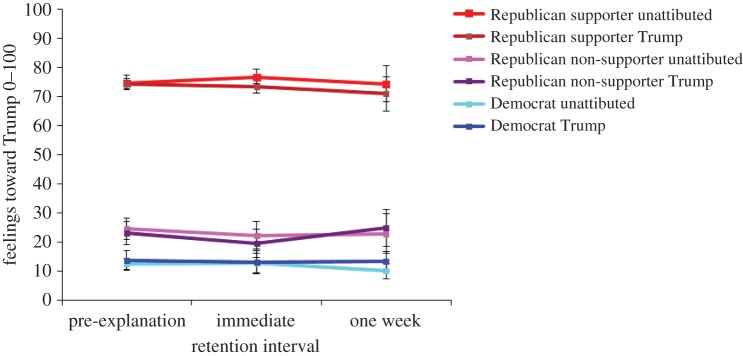
Feelings-thermometer scores over time across partisanship and sources. Error bars denote 95% confidence intervals.